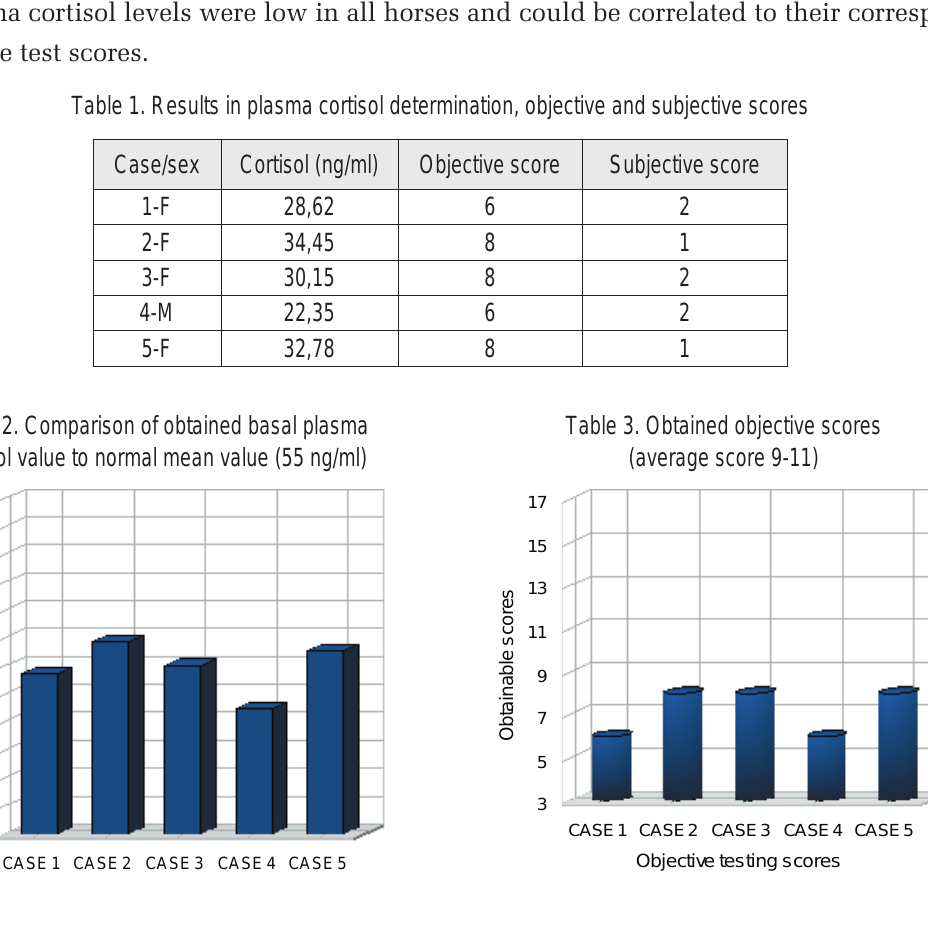
Table 1. Results in plasma cortisol determination, objective and subjective scores Case/sex